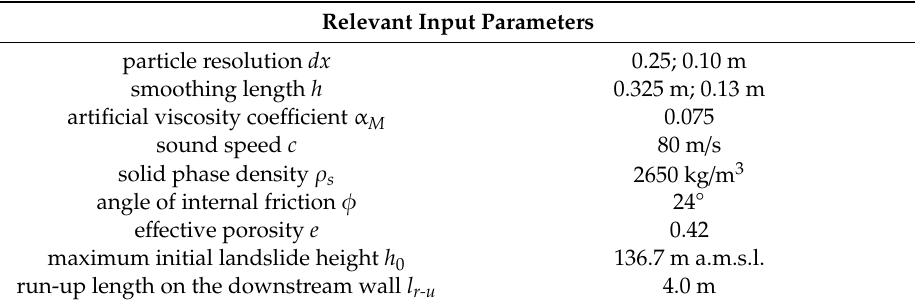
Table 2. Summary of the relevant input